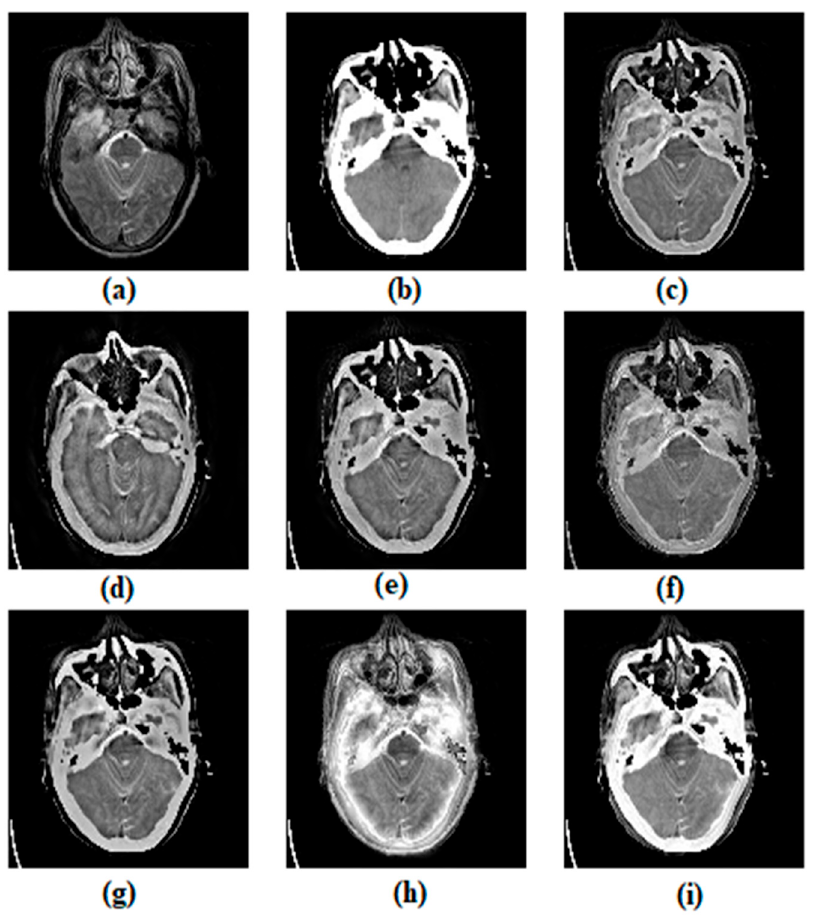
Figure 5. Visual quality analysis of various fusion algorithms for MRI-CT (set-7). ( a ) MRI image, ( b ) CT image, ( c ) ASR, ( d ) CVT, ( e ) DTCWT, ( f ) MSVD, ( g ) CSMCA, ( h ) NSST, ( i ) proposed method.